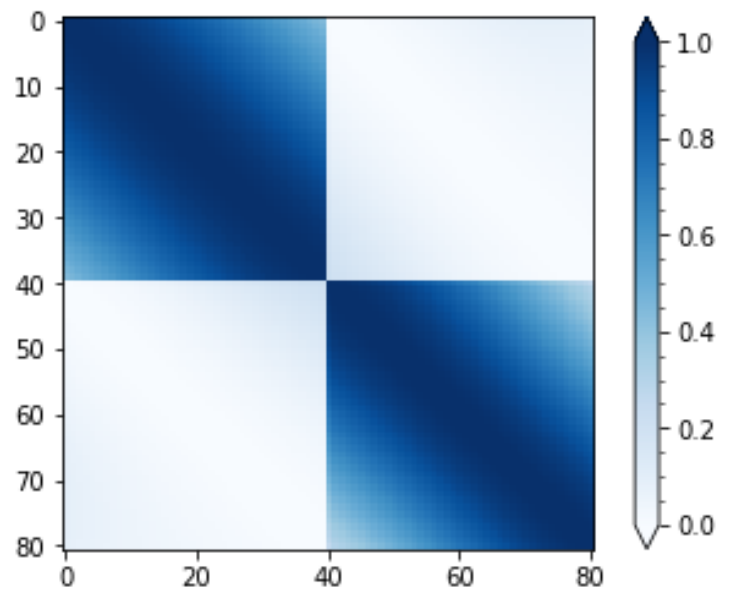
Figure 1. Kernel matrix determined by state vector